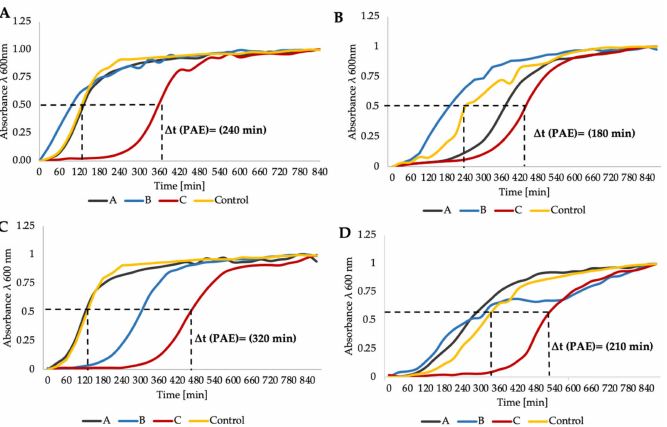
Figure 3. Postantibiotic effect testing. ( A ) Growth curve analysis of aPDI (FL)/GEN combined treatment for E. faecalis ; ( B ) Growth curve analysis of aPDI (FL)/LZD treatment for E. faecium ; ( C ) Growth curve analysis of aPDI (RB)/DOX treatment for E. faecalis ; ( D ) Growth curve analysis of aPDI (RB)/DAP treatment for E. faecium . Phototreatments (aPDI (RB)/(FL)) were employed with 1/2 MIC doses and are presented on graphs with symbols (A). Antibiotics (LZD, DAP, GEN, and DOX) were administered at the MIC and are represented in the figure by symbol B. The combination of light and antibiotics is presented as symbol C (1/2MIC aPDI + MIC antibiotic). Only one representative curve is presented.